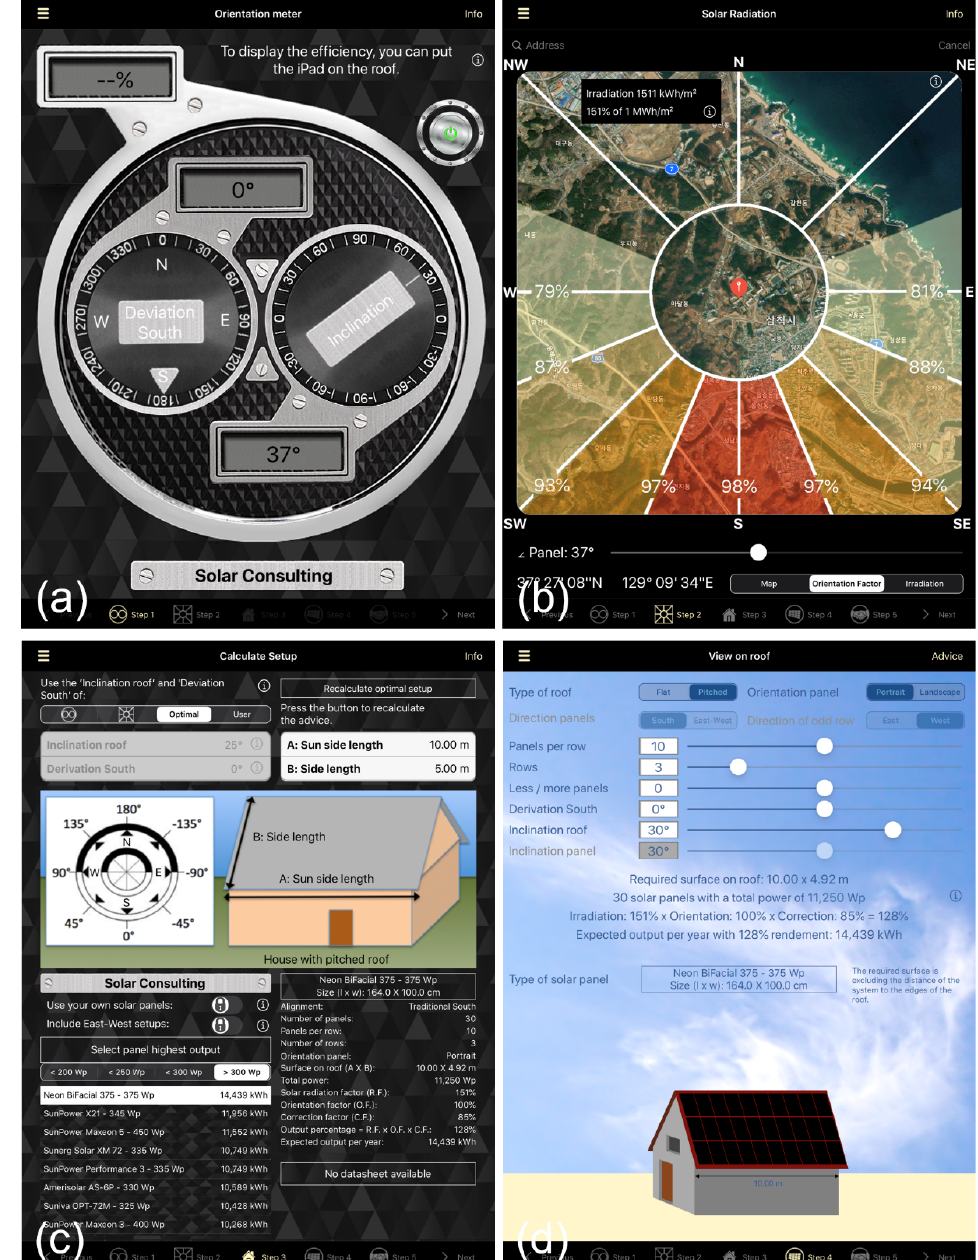
Figure 3. Representative smartphone applications for site evaluation. ( a ) Measurement of tilt and orientation of module, ( b ) Efficiency of solar irradiation according to the module orientation, ( c ) Roof characteristics, and ( d ) Roof PV design using Solar Consult app.